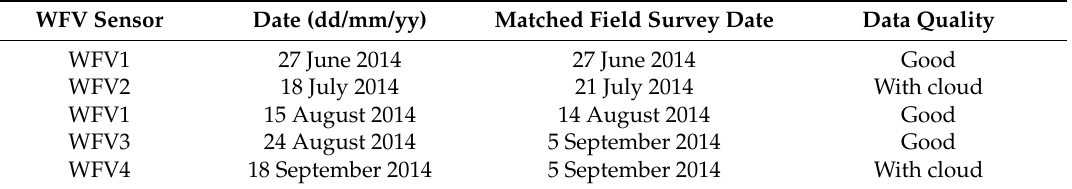
Table 1. The main characteristics of GF-1 wide field view (WFV) data used in this